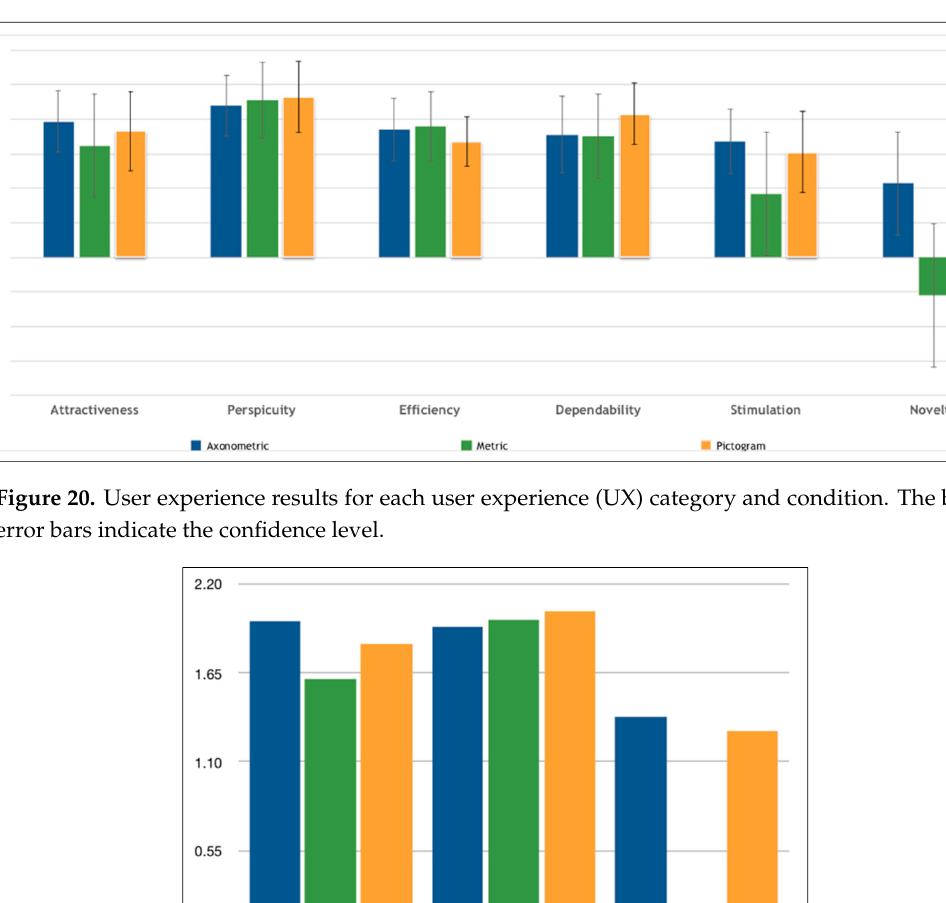
Table 9. Kruskal–Wallis H test results for each of the six user experience categories, for all three conditions (pictogram, axonometric,